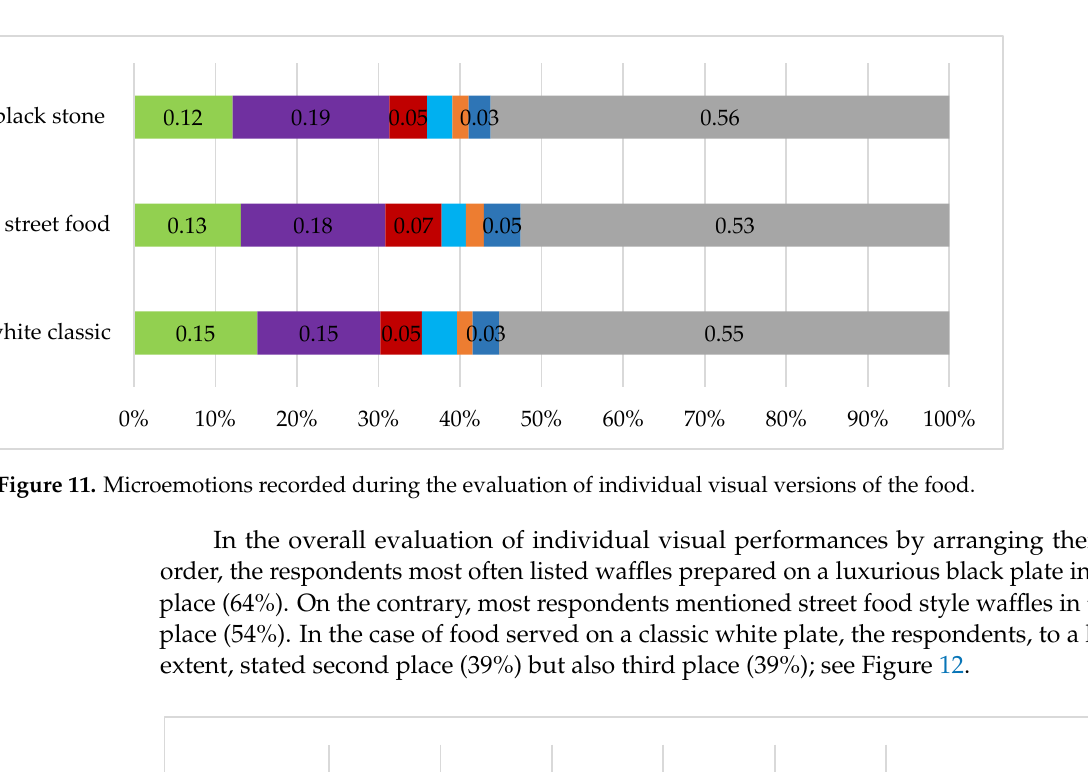
Figure 10. Evaluation of aromas of individual waffle variants.